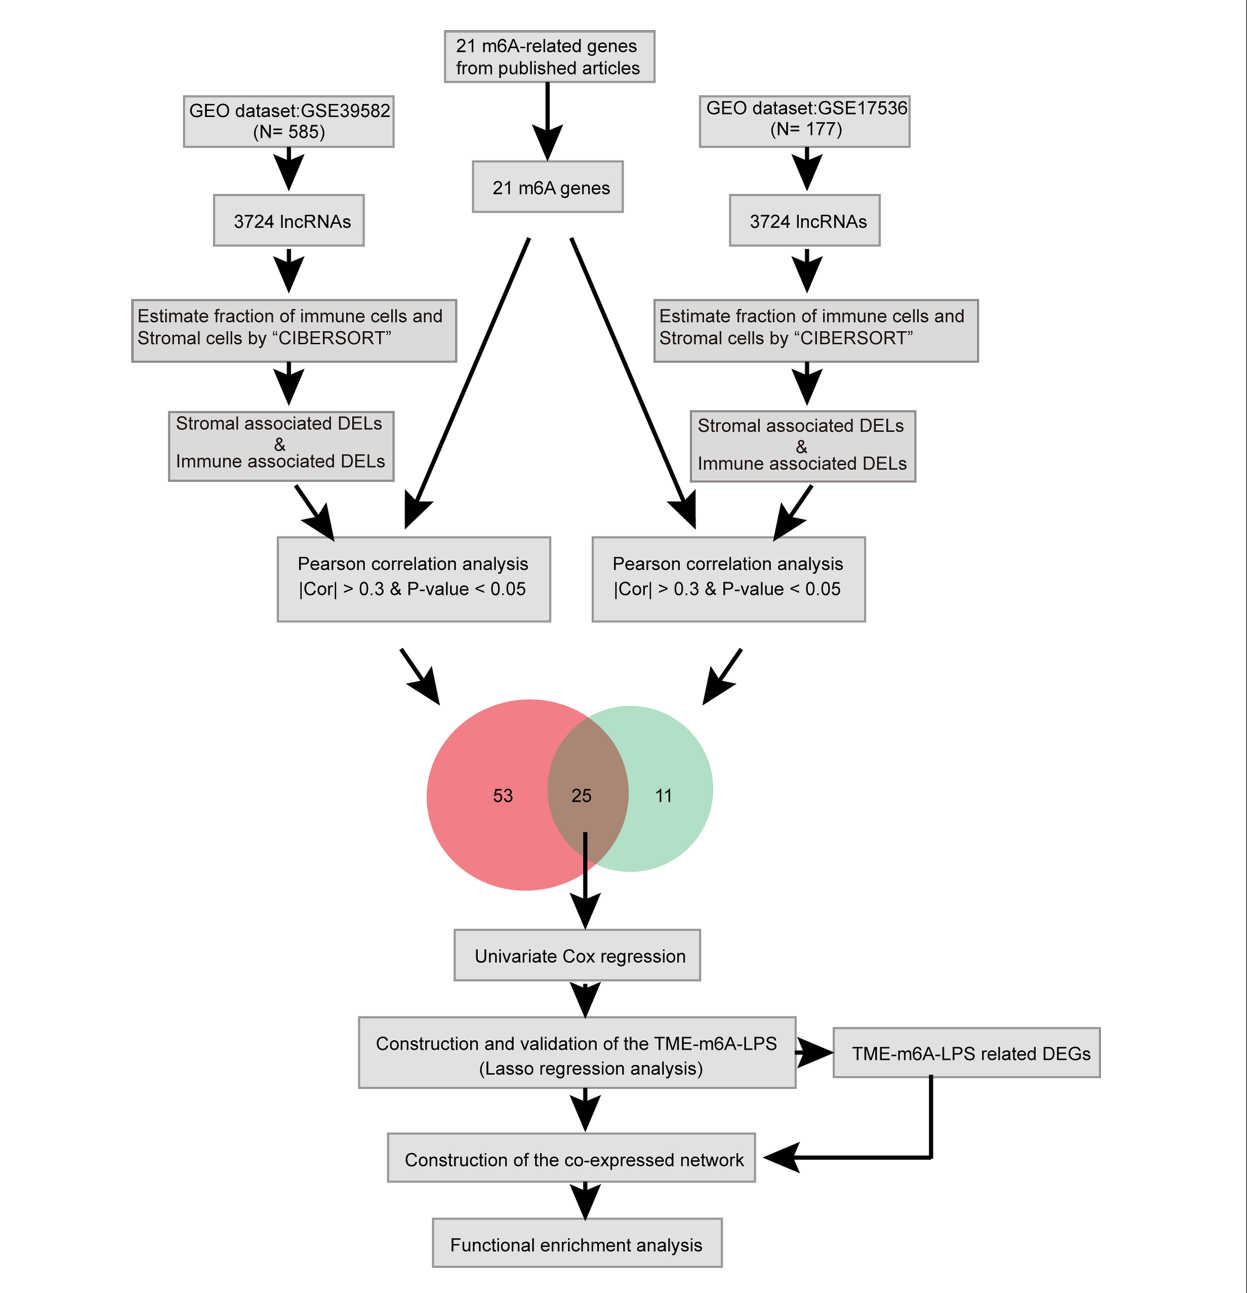
FIGURE 1 | Study fl ow chart of the integration